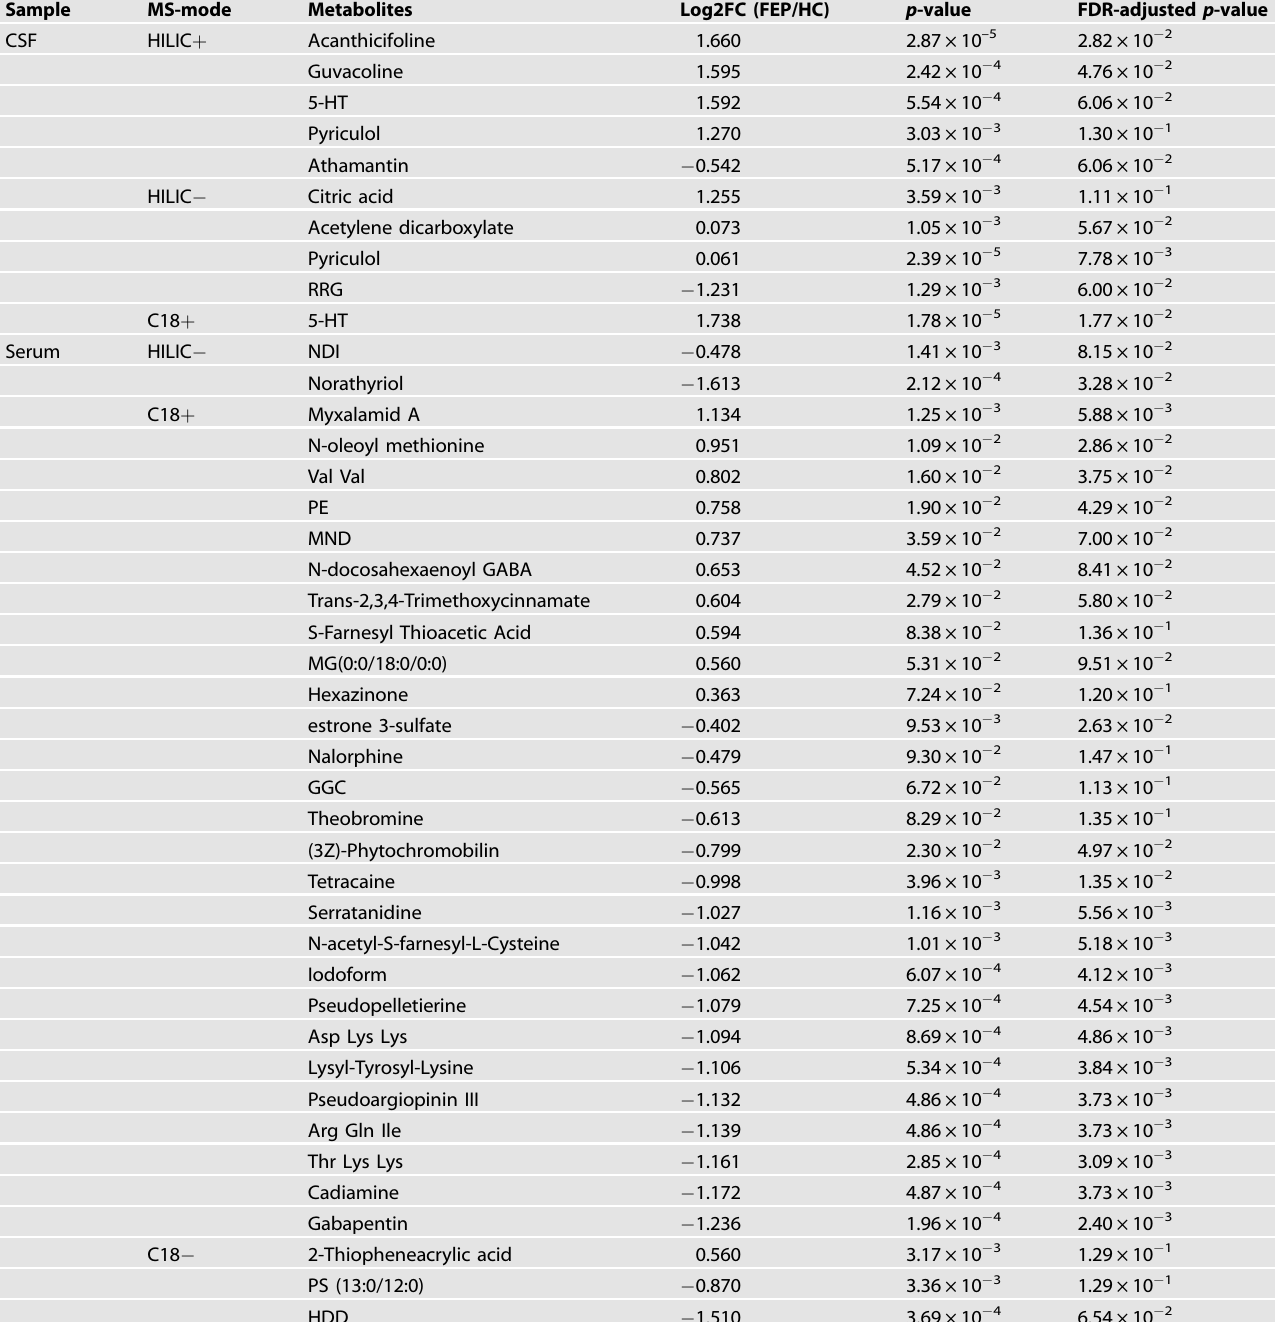
Table 2. List of identi fi ed cerebrospinal fl uid (CSF) and serum metabolites differed between fi rst-episode psychosis patients (FEP) and healthy controls (HC) at baseline, i.e., psychosis-associated